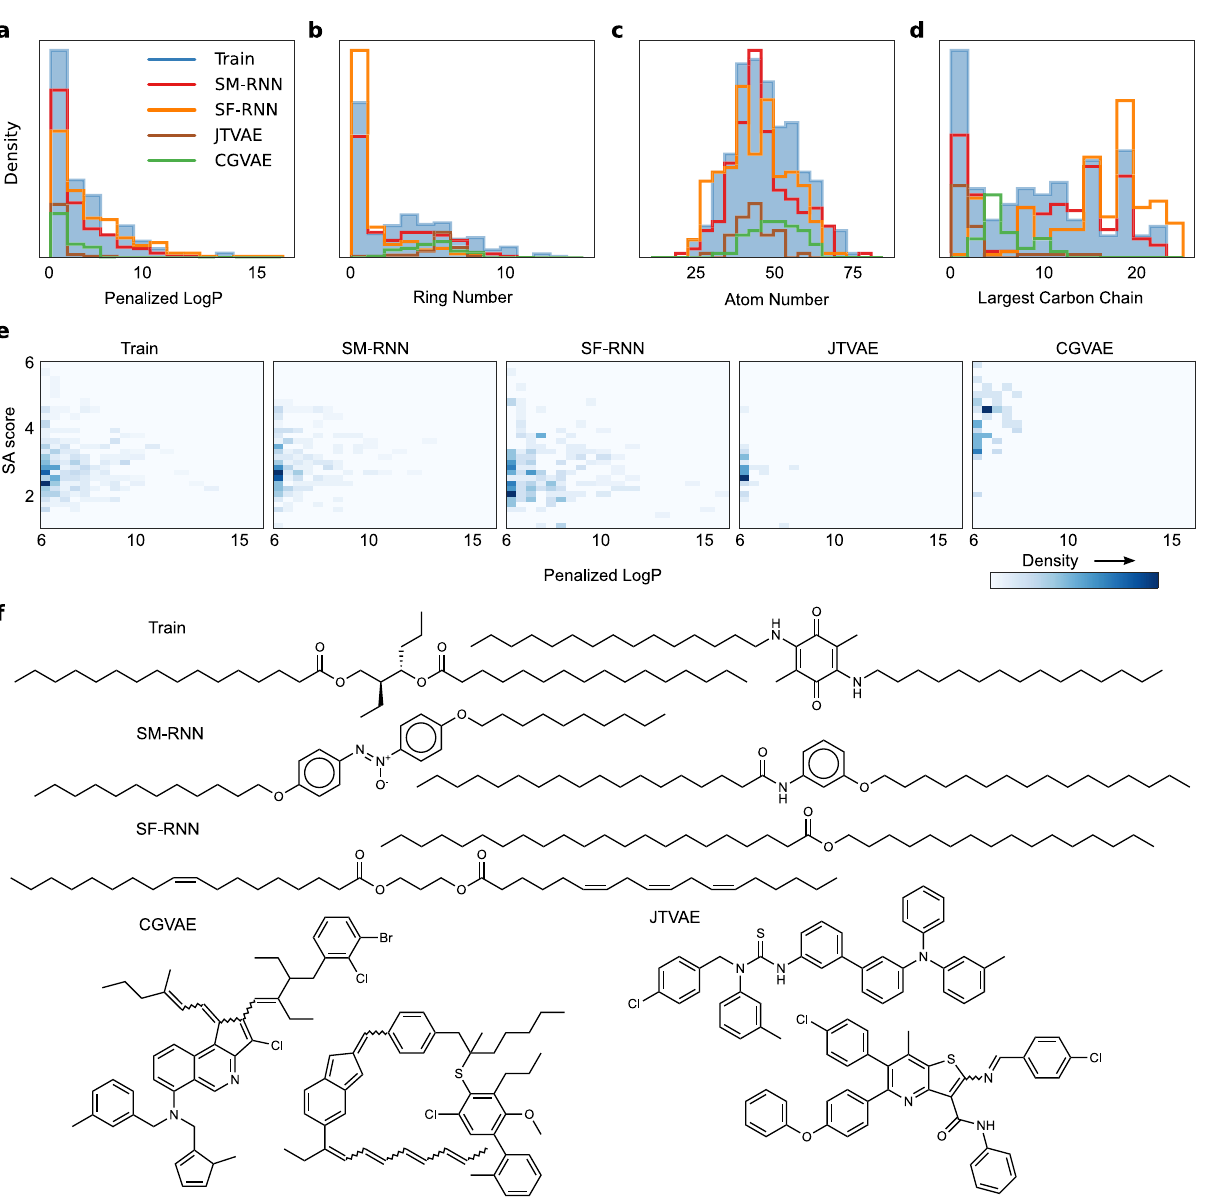
Fig. 3 Penalized LogP Task II. a – d Histograms of penalized LogP, Atoms #, Ring # and length of largest carbon chain (all per molecule) from molecules generated by all models or from the training data that have penalized LogP ≥ 6.0. e 2d histograms of penalized LogP and SA score from molecules generated by the models or from training data that have penalized LogP ≥ 6.0. f A few molecules generated by all models or from the training data that have penalized LogP ≥